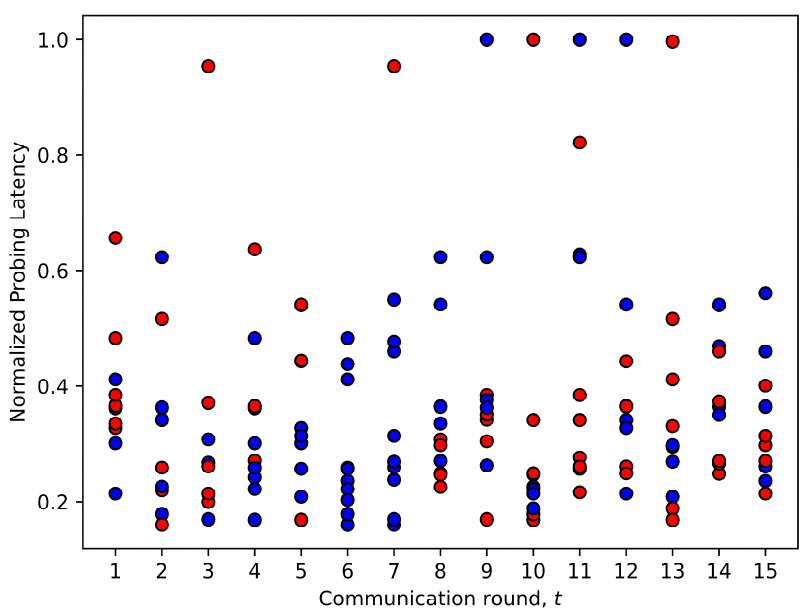
Figure 11. Decisions made by FedDdrl based on probing latency.